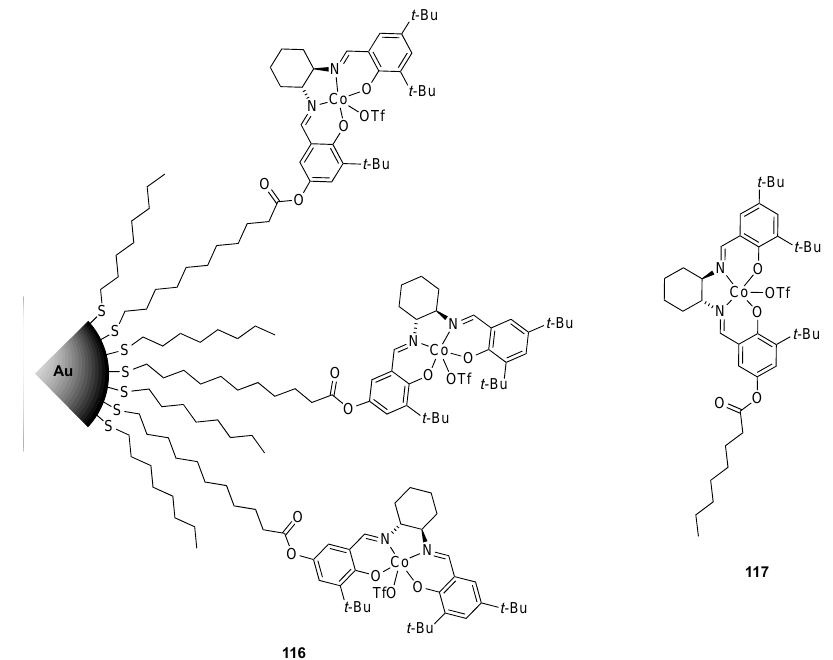
Figure 46. Au colloid-supported Co–salen catalyst 116 and non-immobilized analogue 117 . Catalysts 2020 , 10 , x FOR PEER REVIEW